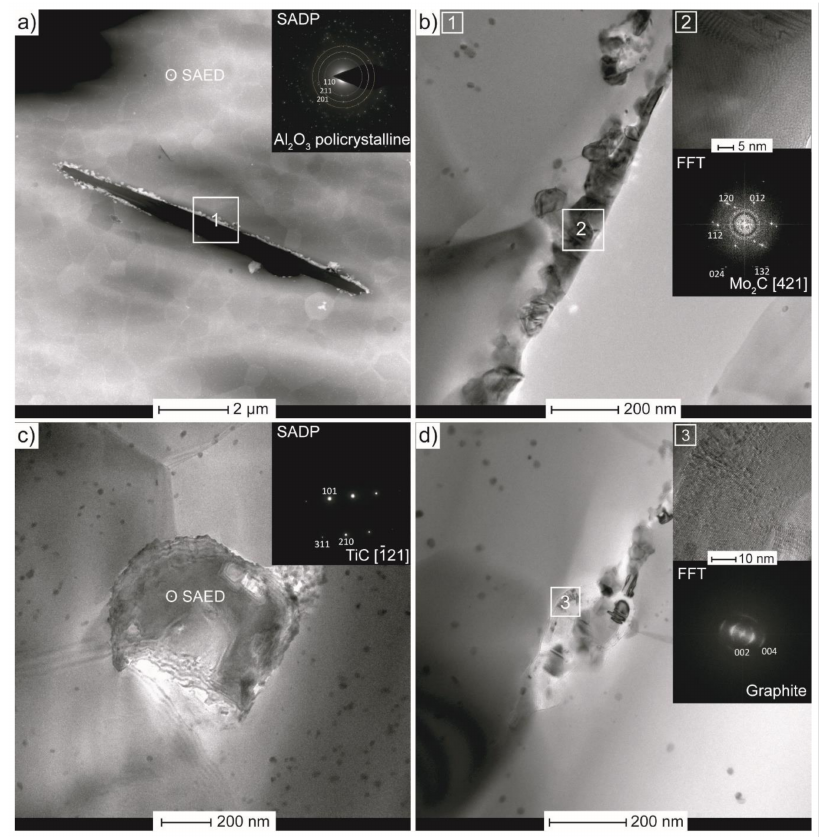
Figure 11. TEM analysis of Al 2 O 3 with 2 wt.% of Ti 3 C 2 -Mo: ( a ) microstructure in high-angle annular dark field (HAADF) scanning transmission mode (STEM) mode with SADP, ( b ) magnified image from elongated void with HRTEM and FFT pattern, ( c ) second phase located between alumina grains with SADP, ( d ) artificial phase at grain boundary with HRTEM and FFT